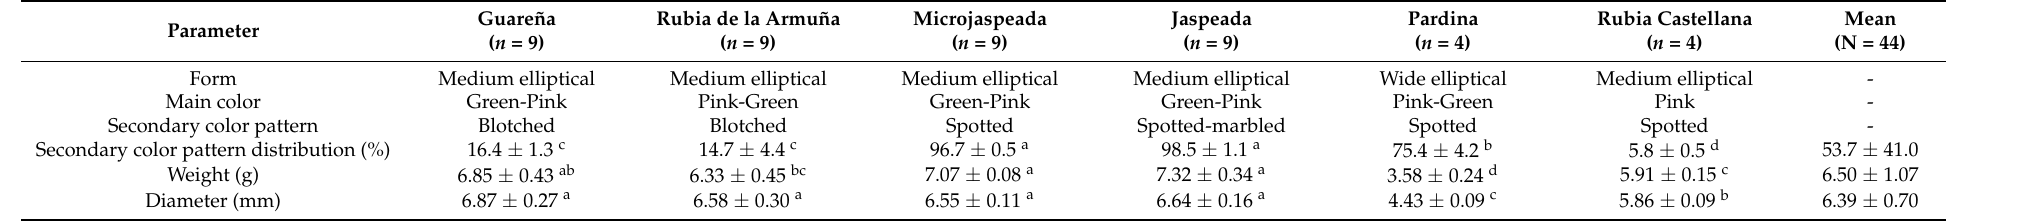
Table 4. Morphometric characteristics of the different lentil varieties (mean ± SD).